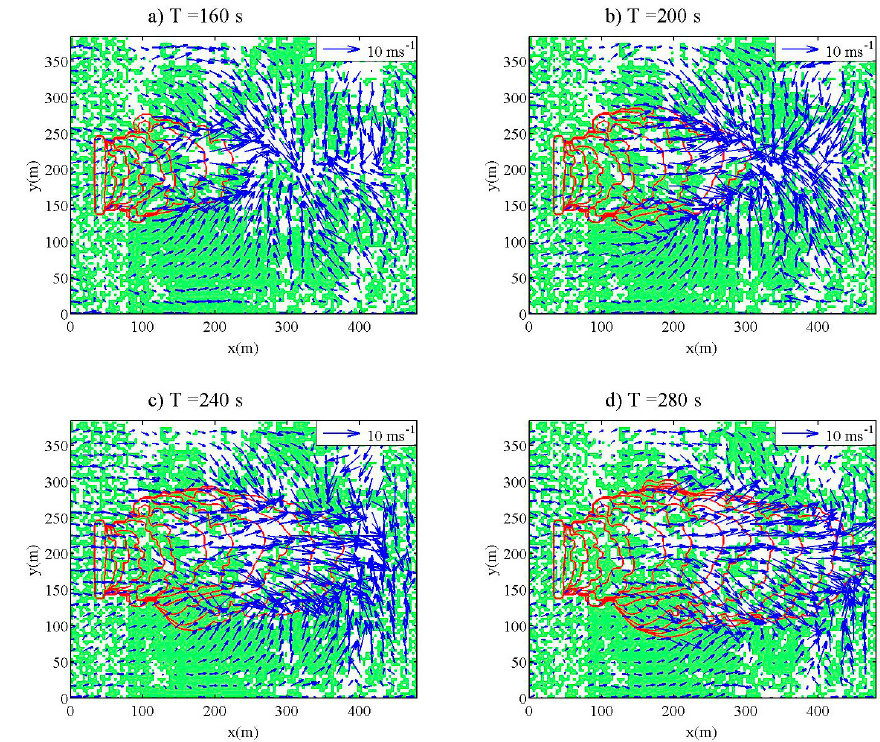
Figure 5. Overhead perspective showing the progression of a single fire, as red fire perimeter contours, in a spatially heterogeneous forest, at four different points in time (t = 160 s ( a ), 200 s ( b ), 240 s ( c ), and 280 s ( d )). Blue arrows indicate wind field direction and magnitude (longer arrows indicate higher local wind speeds), at a height of 9.6 m above the ground. This figure illustrates complex and dynamic interactions between the wind field, the canopy, and the fire over time. Winds coming into the fire at the fire front are typically convective in-drafts.